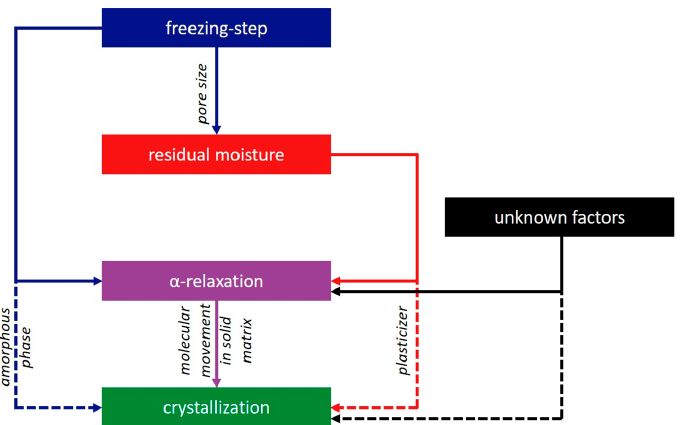
Figure 7. Graphical scheme of the correlation of the investigated parameters. Solid lines were verified by the pre-tests; dashed lines are effects that seem to be proportional to the connected solid line according to the pre-tests.